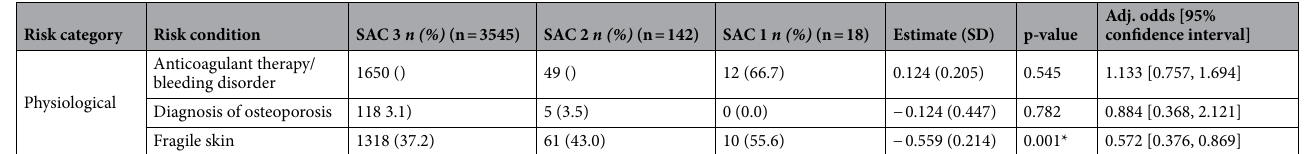
Table 3. Multivariable analysis of patient’s medical and health risk factors associated with the severity level of fall. NB: Patients with risk condition present were set as reference group in the model. *Denotes significant association at 5% level of significance. The reported adjusted odds estimates are also age-gender